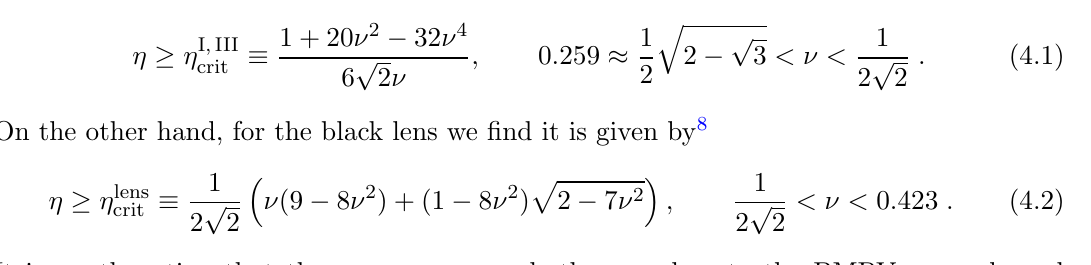
Figure 8. (cid:17) crit for (a) the black lens and (b) the spherical black holes I and III. the same area function a ( (cid:17); (cid:23) ), so in both cases this subregion is given H